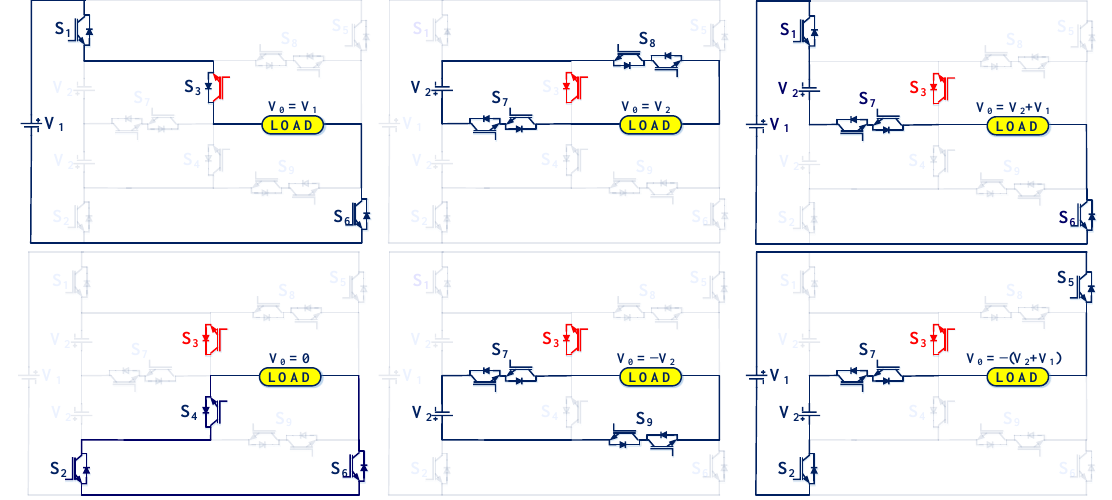
Figure 4. Bypassing of faulted S 3 by body diode and following conduction states. 3. Fault IN S 7